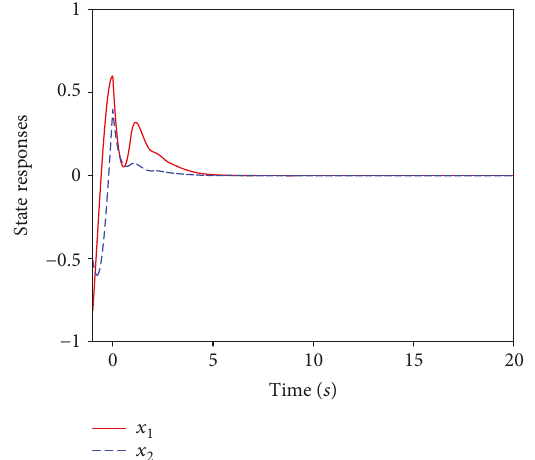
Figure 7: State responses of subnetwork 1 of the considered SNNs for Example 2.